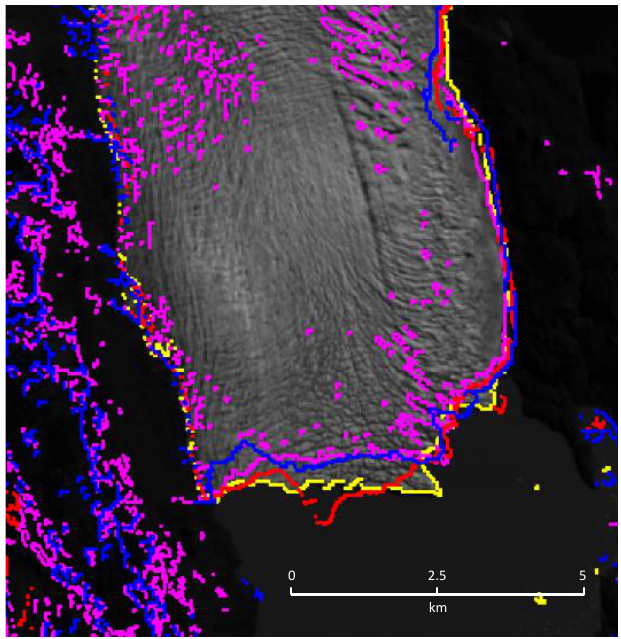
Figure 11. Glacier snout with glacier end line (break-off edge) for the years of 2016 (yellow), 2017 (pink), 2018 (red) and 2019 (blue). The underlying image is of